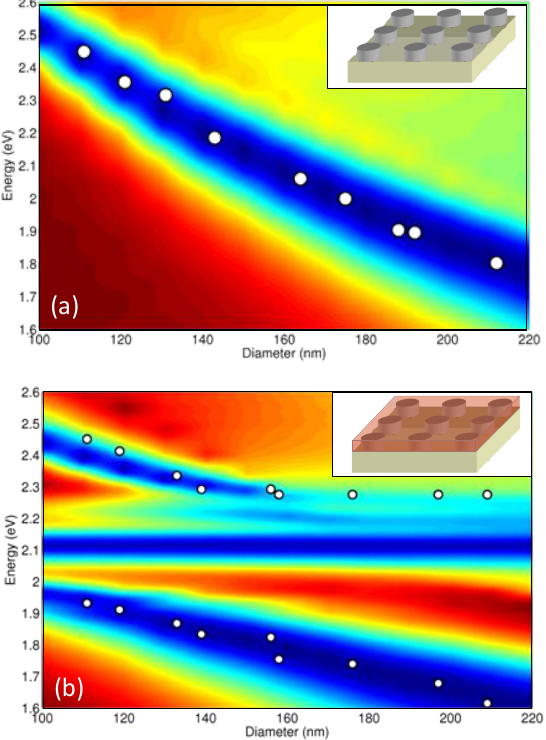
Figure 4. Measured energy of the transmission dips (white circles) as a function of the disk diameter and 3D FDTD calculated transmission spectra for ( a ) a bare sample and ( b ) a sample covered with a TDBC